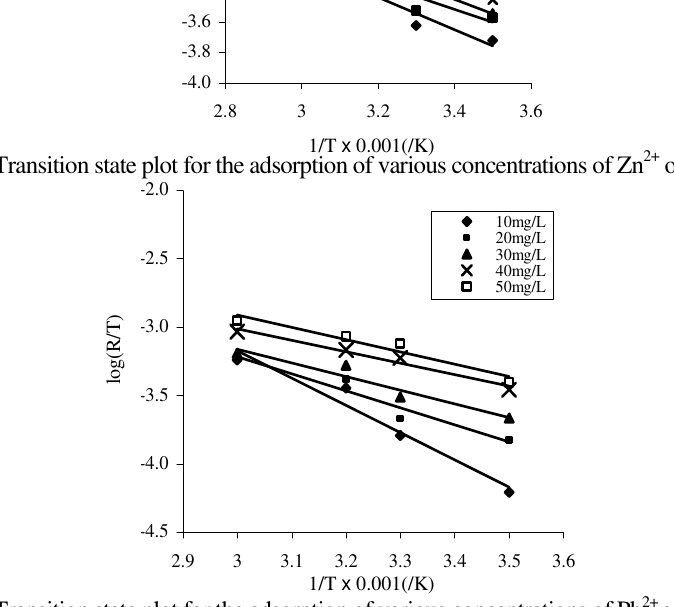
Figure 8. Transition state plot for the adsorption of various concentrations of Pb 2+ onto human